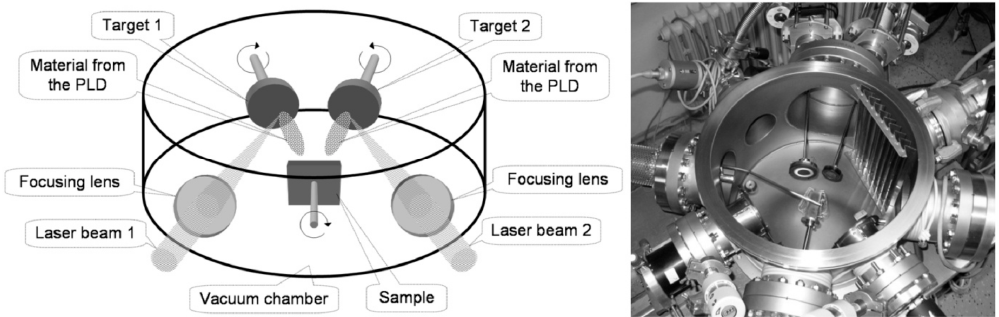
Figure 1. Dual beam laser deposition (schema—left, photo of chamber—right). Table 1. Deposition conditions, Ge concentration, and film roughness (Ra) for germanium-doped diamond-like carbon (Ge-DLC) films prepared by double pulsed laser deposition (PLD) arrangement.